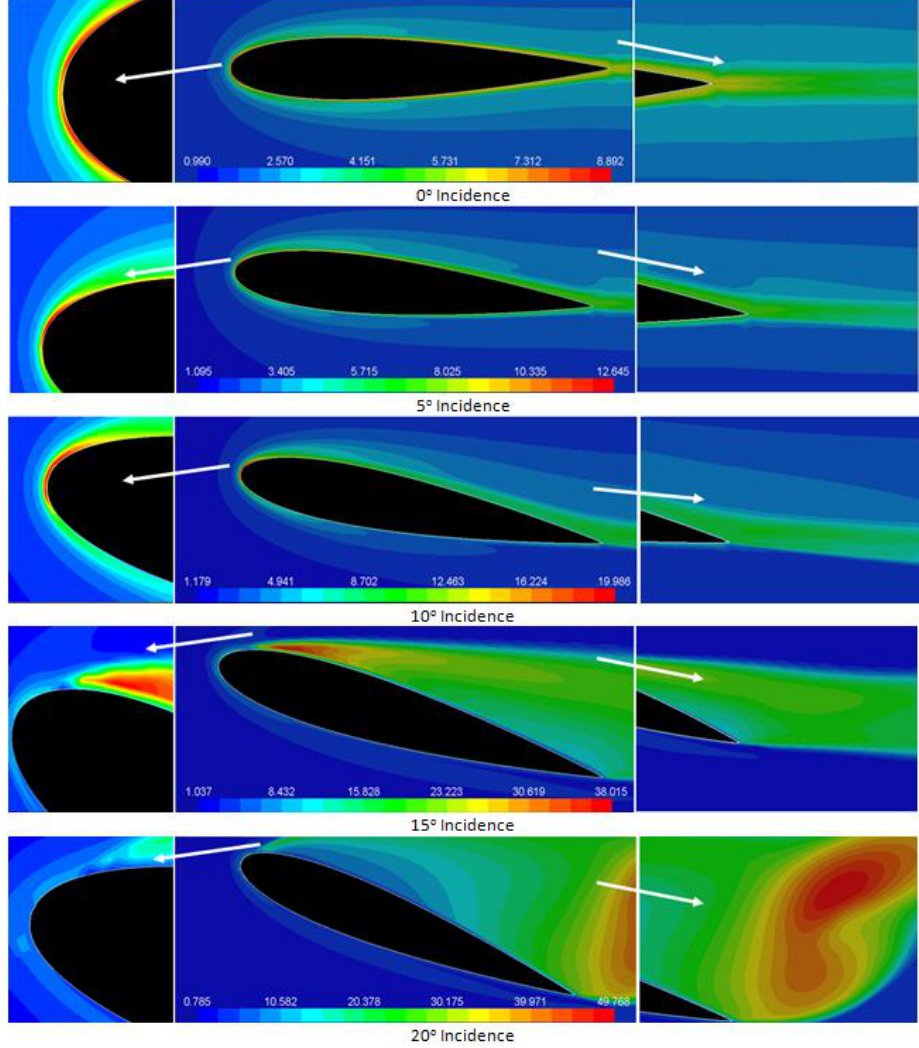
Figure 14. Turbulence intensity contours (%) for flow around the airfoil at various incidence angles. Enlarged views of certain regions are shown on the contours on the left and right for clarity.